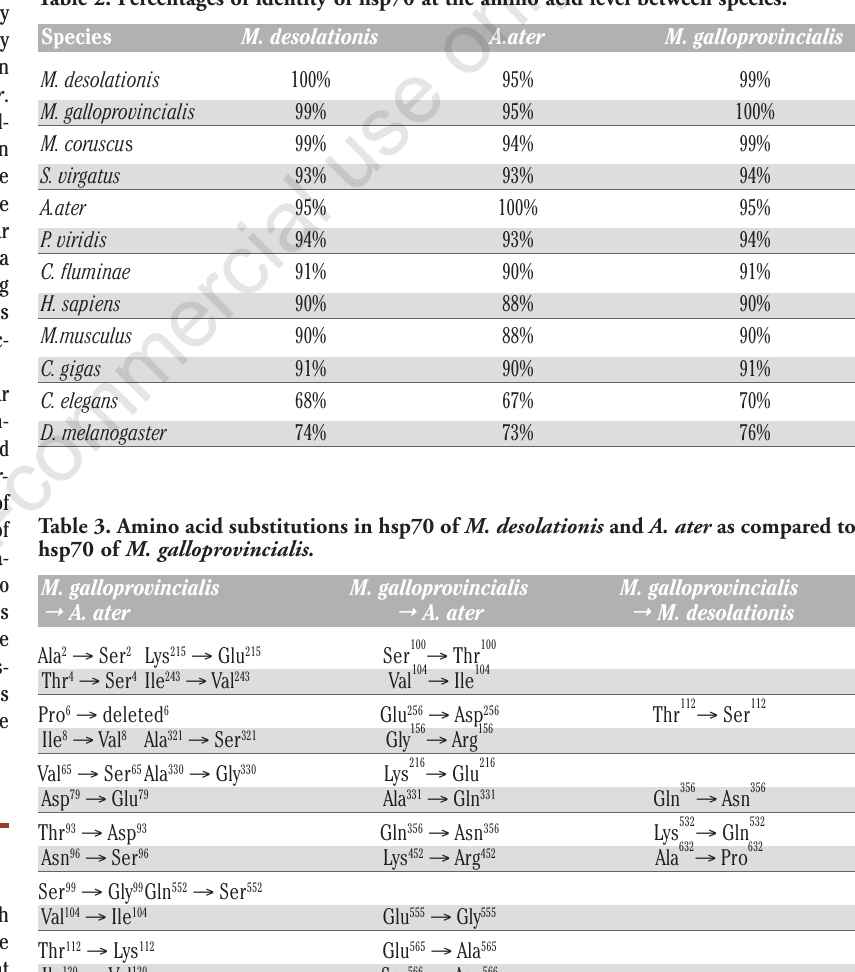
Table 2. Percentages of identity of hsp70 at the amino acid level between species.